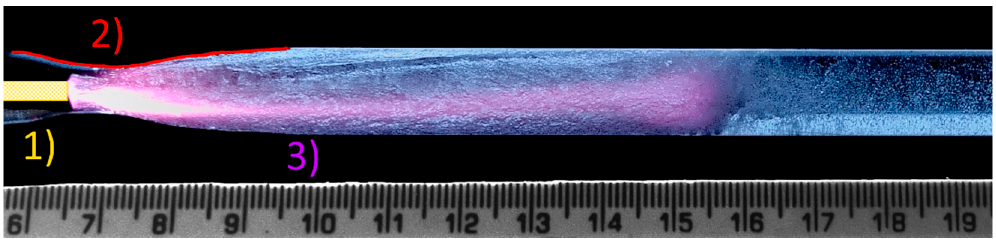
Figure 1. A HCPJ generated in a Venturi nozzle with the flow of 0.55 m 3 /h at sub-atmospheric backpressure of 40 kPa. Plasma was initiated using an HV sine-wave generator with the frequency of 65 kHz. HV measured at electrodes was 6.4 kV peak-to-peak. Power was set to 400 W measured at the HV power supply input. Exposure time was 1/20 s. The positions of the HV electrode ( 1 ) and outer contour of the Venturi nozzle ( 2 ) are indicated by the yellow and red colors, respectively. The discharge channel ( 3 ) was generated inside a cavitation cloud. The electrodes were separated by approximately 16 cm.